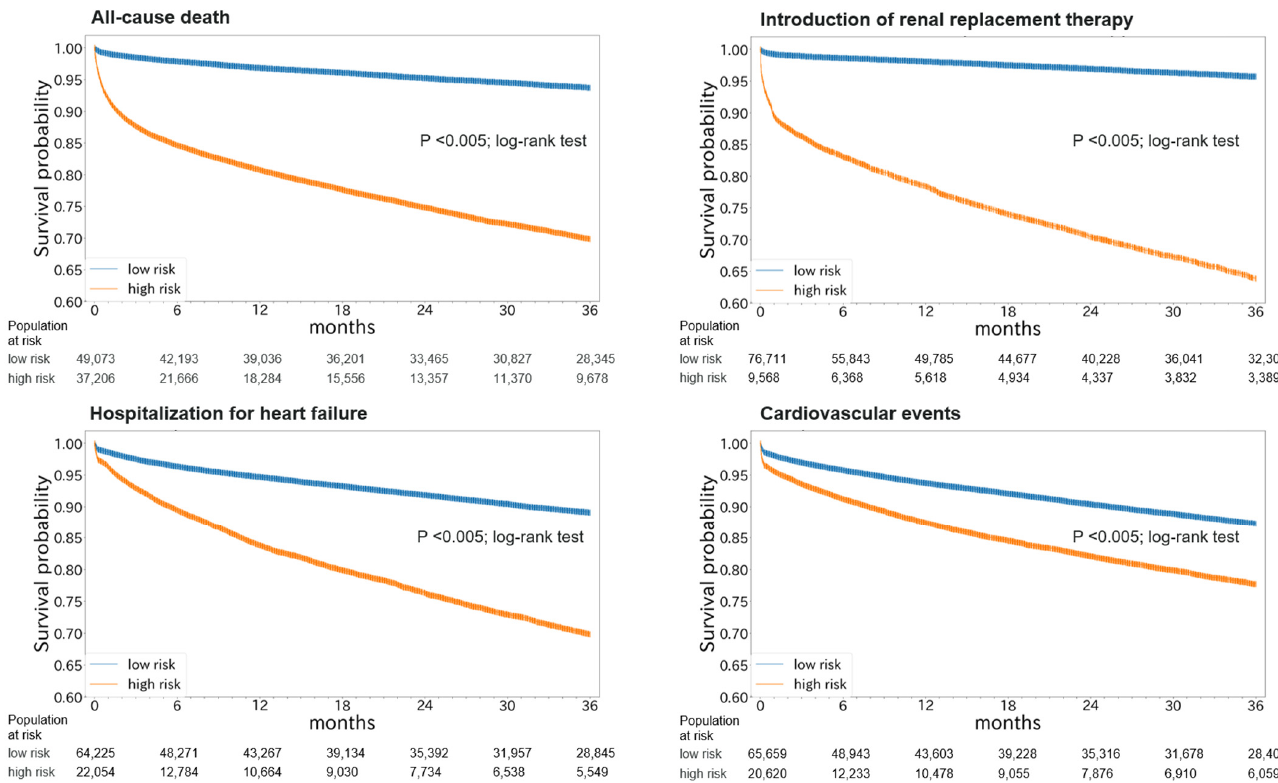
made based on the best-cut off values. The best cut-off point was set as the cut-off value to the point on the ROC curve that maximizes the sum of sensitivity + specificity − 1, i.e., the Youden index that provides efficient tradeoff between sensitivity and specificity.